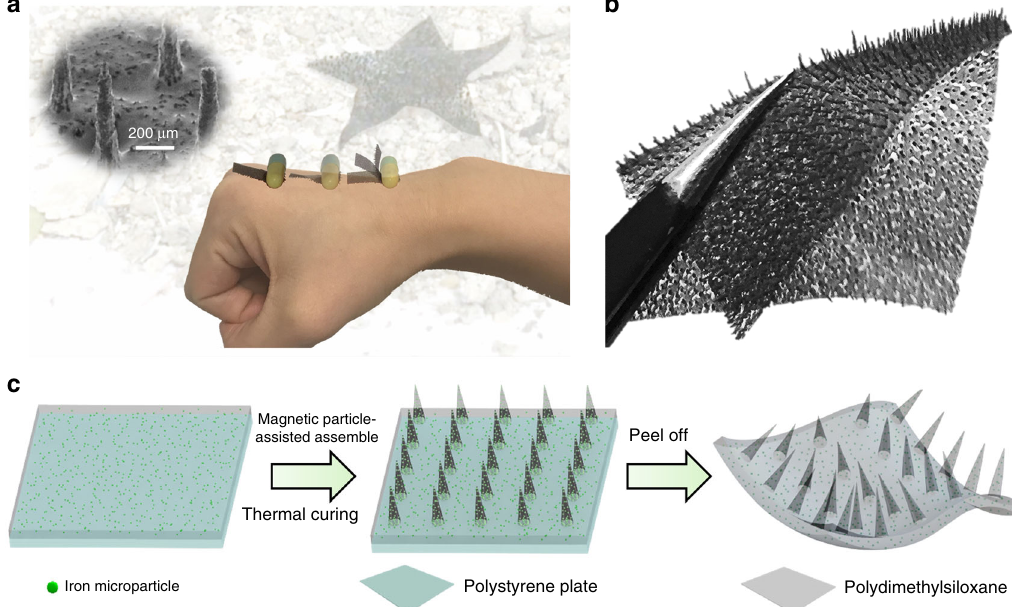
Fig. 1 Multi-legged millirobot with fl exible tapered feet. a Optical image of the soft robot with fl exible tapered feet structure that exhibits superior adaptability, fast speed, heavy carrying – load ability, and excellent over-obstacle ability. b Optical image of the as-developed soft robot decorated with tapered feet. The thickness of body, foot length, and foot-to-foot spacing of robot is ∼ 150 μ m, ∼ 650 μ m, and ∼ 600 μ m, respectively. The tip angle of the tapered feet is ∼ 15°, and the Yong ’ s modulus of the as-fabricated soft body is measured to be ∼ 2MPa. c Schematic of robot fabrication process using a modi fi ed magnetic particle- assisted molding approach. Mixture containing polydimethylsiloxane (PDMS) pre-polymer and iron microparticles are fi rst deposited on a polystyrene plate via spinning coating. Then, a magnet bar is put underneath to induce the formation of tapered feet under the guidance of magnetic fi eld. After a solidi fi cation in a convection oven for thermal curing for 1h at 80°C, the as-fabricated fi lm is peeled off from the plate and cut into the rectangular